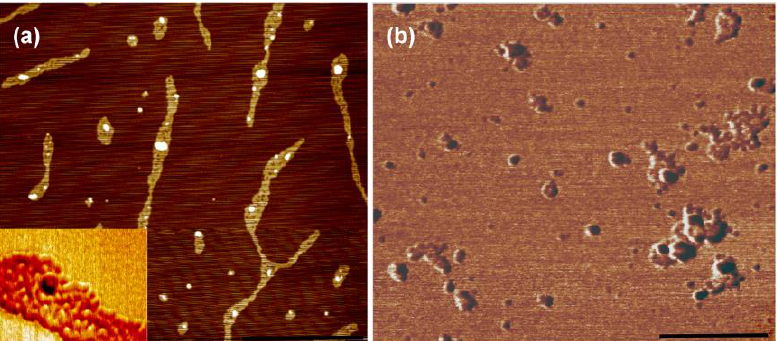
Figure 8. ( a ) Tau fibrils grown at 37 ◦ C. Scale bar = 1 µ m (inset = 100 nm). ( b ) Tau fibrils after association with to TauRP1-14 for 24 h. Scale bar = 500 nm.